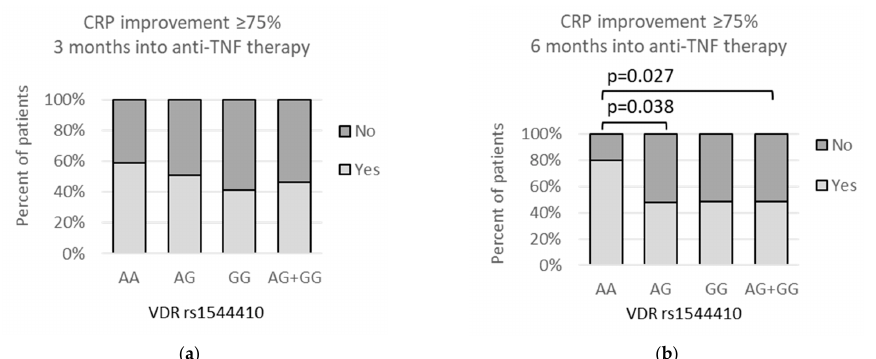
Figure 5. Relationships between VDR rs1544410 polymorphism and percent of patients achieving CRP improvement of ≥ 75% after ( a ) 3 months of anti-TNF therapy, and ( b ) 6 months after beginning of the treatment. The following statistically significant associations were found: ( b ) AA vs. AG , p = 0.038, OR(95%CI) = 4.36 (1.06 to 15.7); and AA vs. AG + GG , p = 0.027, OR(95%CI) = 4.29 (1.20 to 14.8). Analysis was performed using Fisher‘s exact test.